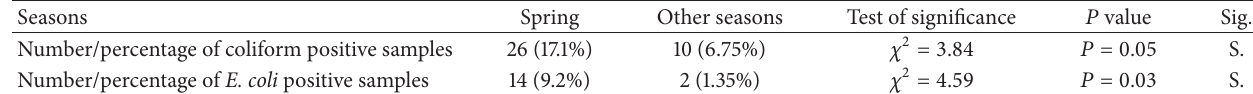
Table 3: Distribution of positive coliform and E. coli isolates among seasons of the year.